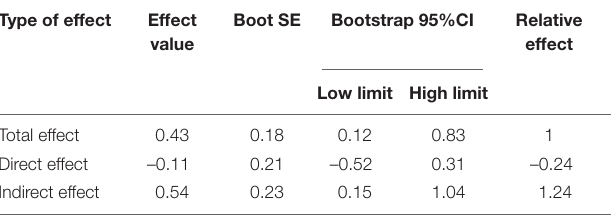
TABLE 4 | Mediating